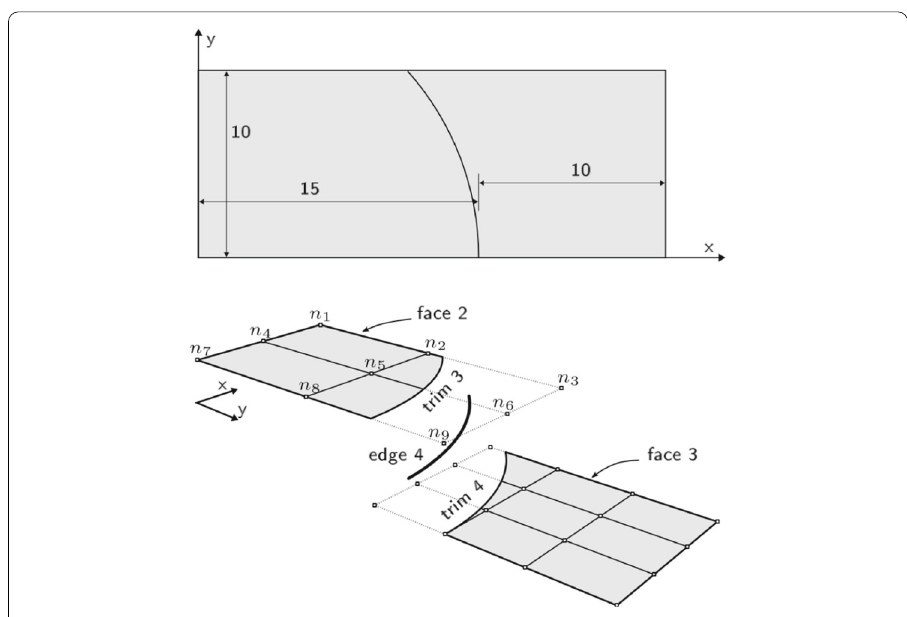
Fig. 18 Example two coupled trimmed patches: Two trimmed surfaces with one common edge and their control